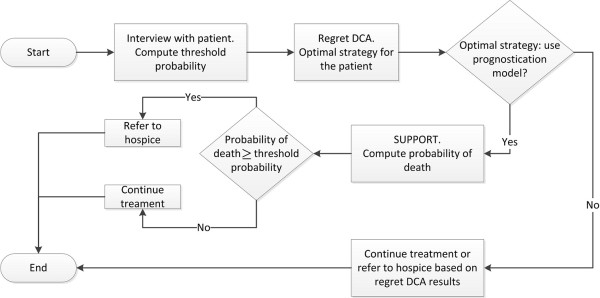
Block diagram outlining the operation of the DSS.